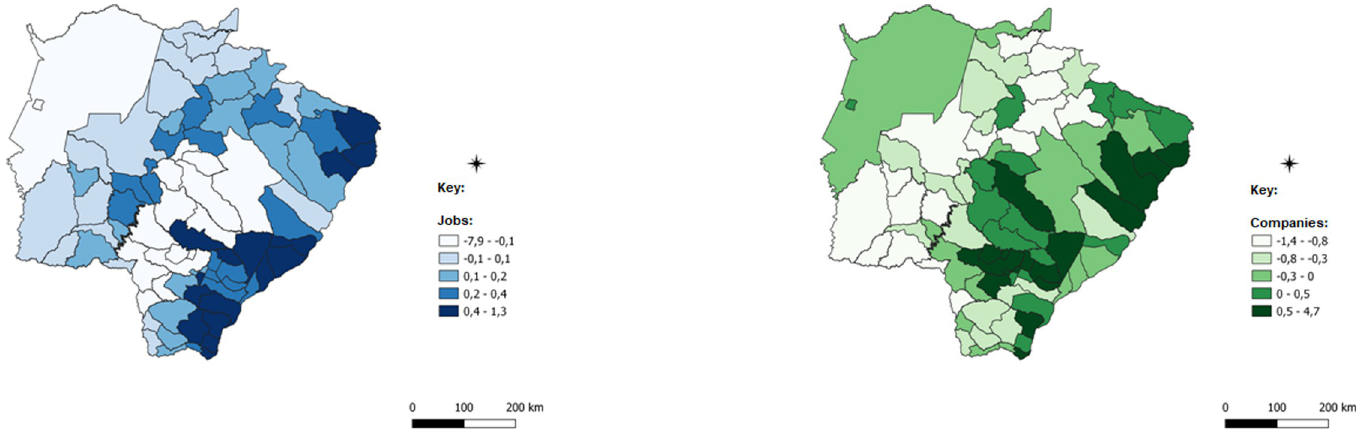
Fig 6. Industry spatially weighted composite concentration index. Caption credit: Elaborated from secondary data extracted from [26].